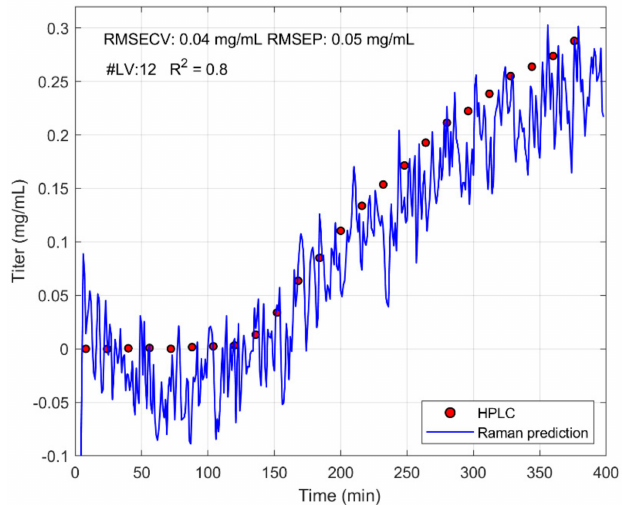
Figure 3. Time evolutions of Raman-PLS predictions (blue) for rotation 1 (ROT1) compared to o ff -line HPLC measurements (red).